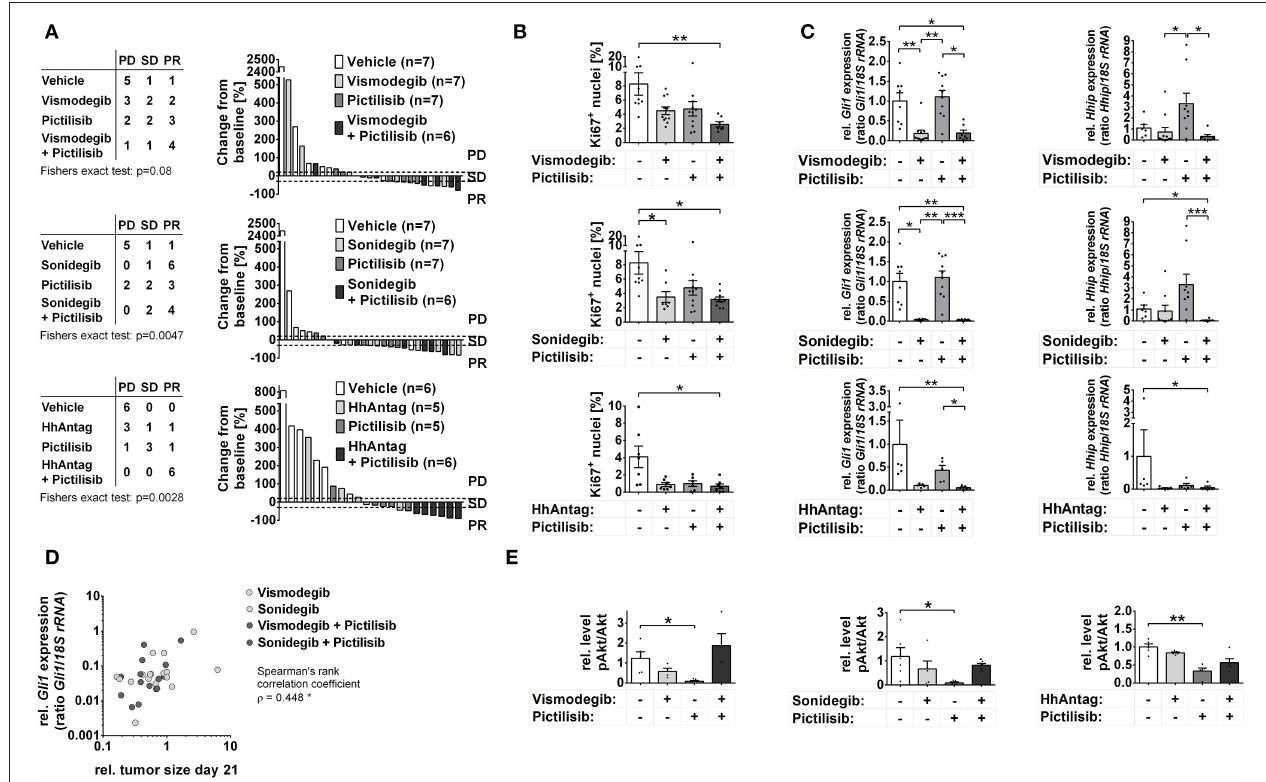
FIGURE 2 | Effects of Smo and/or Pi3k inhibition on in vivo growth of Ptch mutant ERMS. Analysis of RMS of Ptch + / − mice that have been treated orally for 21 (vismodegib and/or pictilisib n = 27; sonidegib and/or pictilisib n = 27) or 35 days (HhAntag and/or pictilisib n = 22) as indicated. (A) Disease progression was classified according to RECIST criteria as progressive disease (PD), stable disease (PD) or partial response (PR). Right panel shows individual changes in tumor growth as measured by microCT at therapy end in comparison to the tumor size at therapy onset. (B) Quantification of Ki67 positive cells of tumors shown in A) . (C) Gli1 and Hhip expression in tumor samples collected at day 21 (vismodegib and/or pictilisib study or sonidegib and/or pictilisib study) or day 14 (HhAntag and/or pictilisib study; see main text for explanation). (D) Correlation of tumor growth changes that have been treated with SMO inhibitors with Gli1 expression. (E) pAkt normalized to